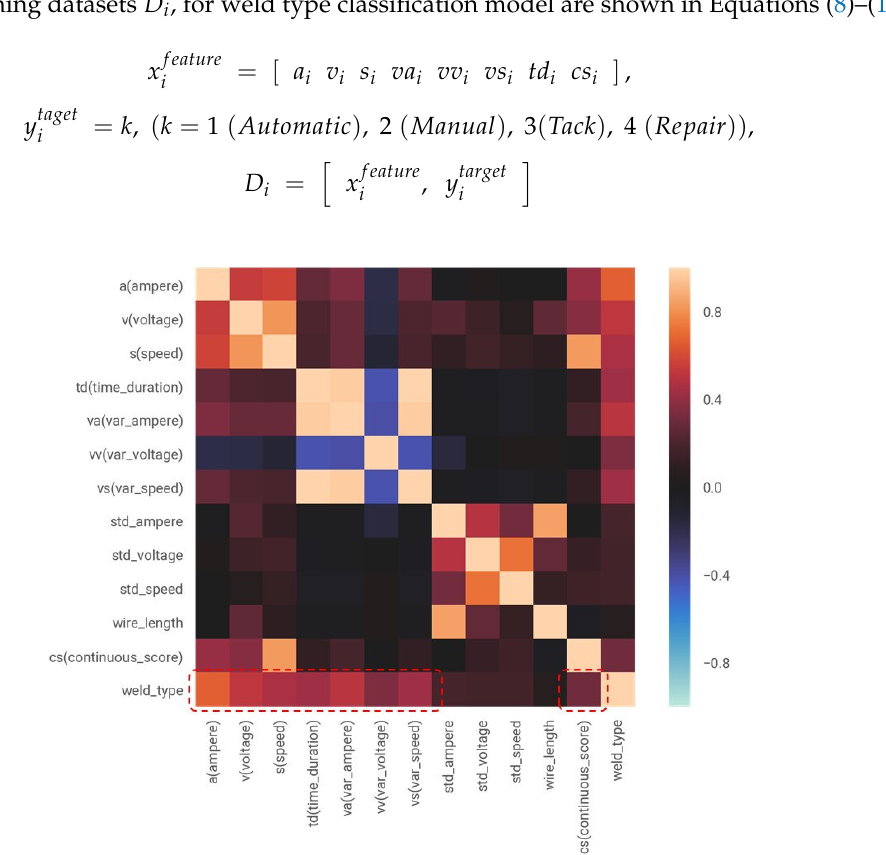
Figure 15. The correlation matrix between feature variables.